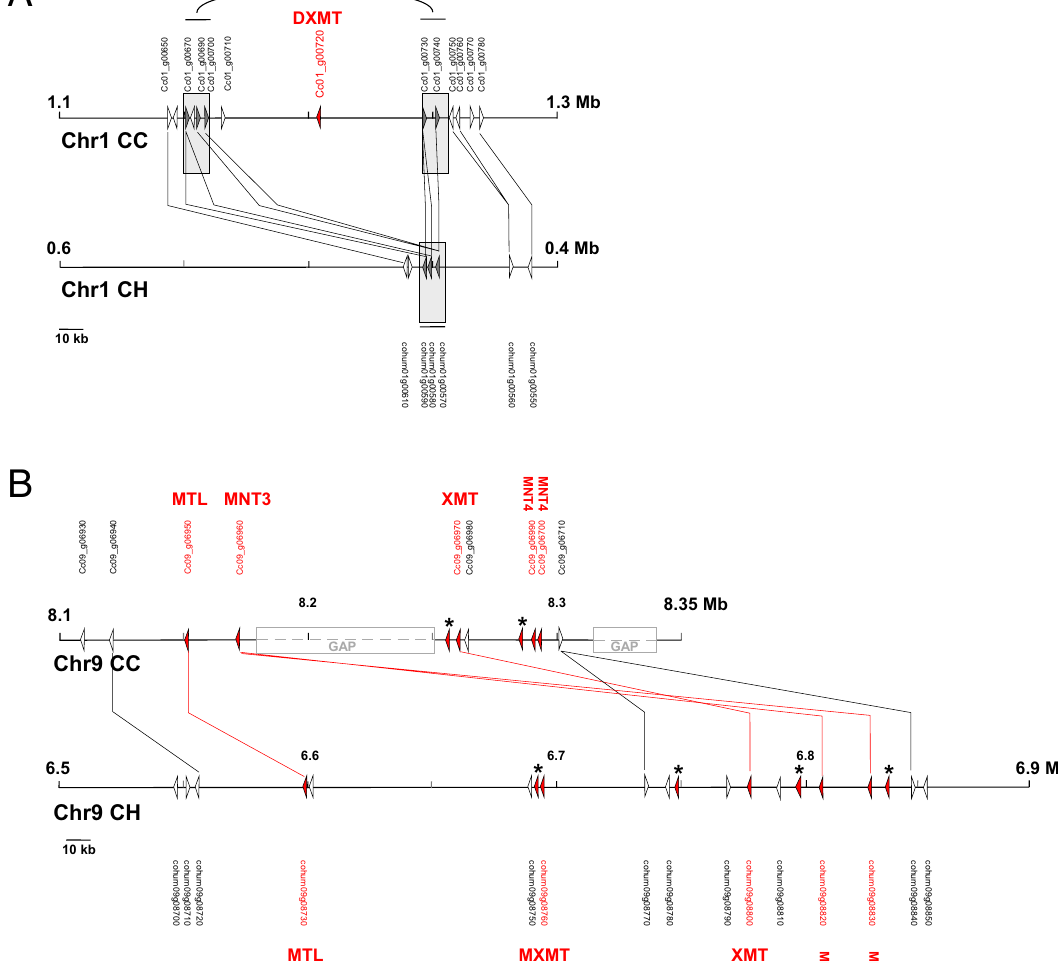
Figure 5. Microsynteny between C. canephora (CC) and C. humblotiana (CH) at the DXMT locus on chromosome 1 ( A ) and at the MXMT/XMT locus on chromosome 9 ( B ). ( A ) Representation of the microsynteny between C. canephora (CC; chromosome 1 position 1.1–1.3 Mb) and C. humblotiana (CH; chromosome 1 position 0.4–0.6 Mb). The DMXT gene, only present on C. canephora is indicated in red. The shaded boxes indicate the duplicated region in CC versus CH. ( B ) Representation of the microsynteny between C. canephora (CC; chromosome 9 position 8.1–8.35 Mb) and C. humblotiana (CH; chromosome 9 position 6.5–6.9 Mb). MTL genes are indicated in red. Asterisks indicate pseudogenes. In Grey are indicated the position of gaps in the assembly of the C. canephora genome. Triangles indicate the position and orientation of coding regions. Lines indicate the conservation of genes named by their